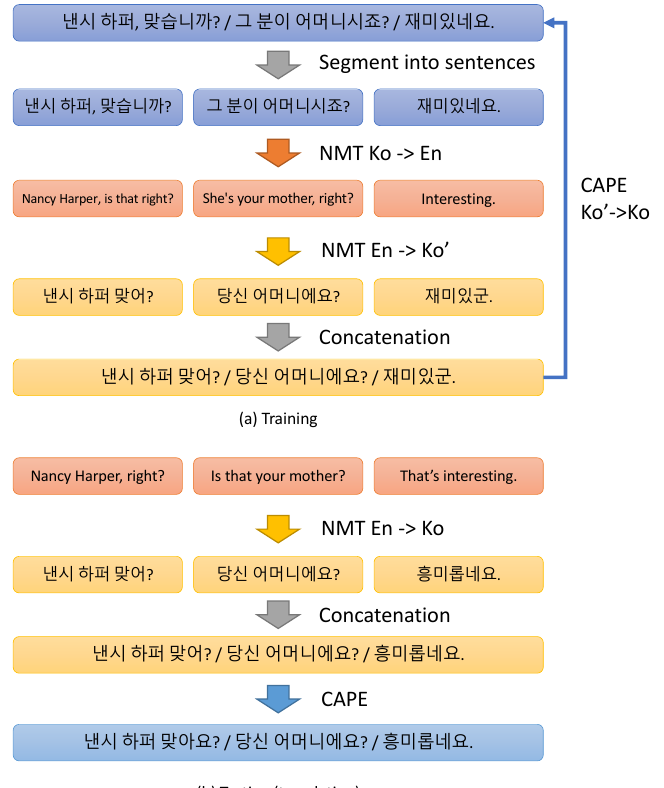
Figure 4. ( a ) Training a CAPE model requires a monolingual, discourse-/document-level corpus. Each consecutive text is segmented into a set of sentences first. Then, each sentence is translated and then back-translated. The resulting sentence group is concatenated again, and then the CAPE, which consists of a sequence-to-sequence model, is trained to minimize the errors of these round-trip translations. ( b ) At test time, a trained CAPE fixes sentence-level translations by taking them as a